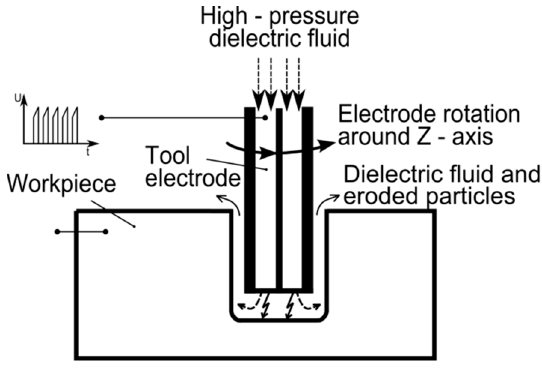
Figure 1. Scheme of EDM drilling [10].